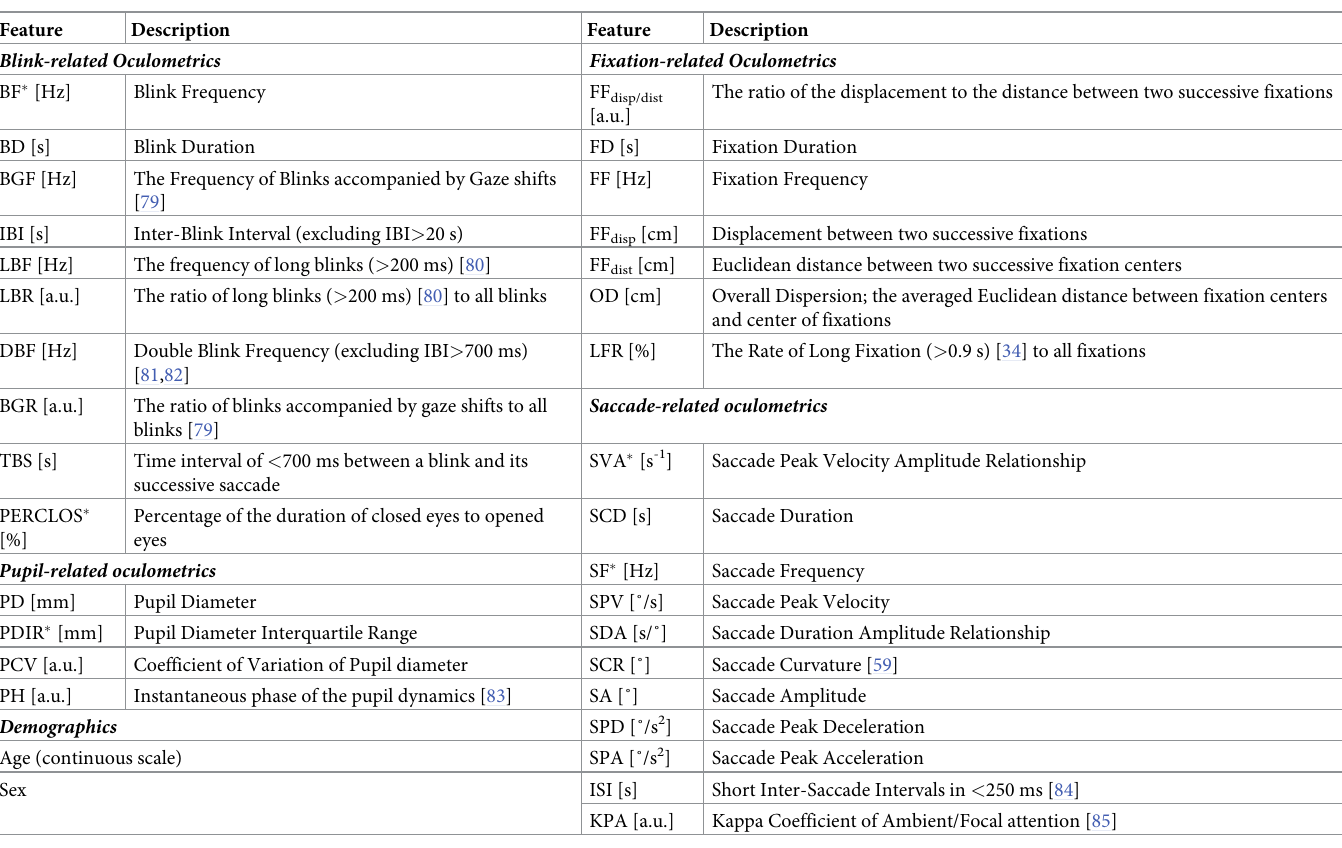
Table 1. The feature